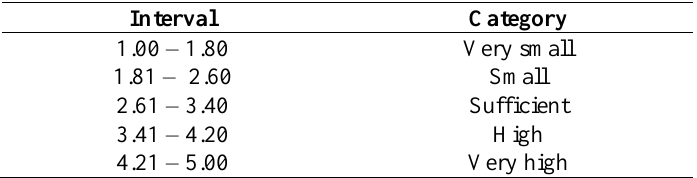
Table 1 Scale Range of Brand Loyalty